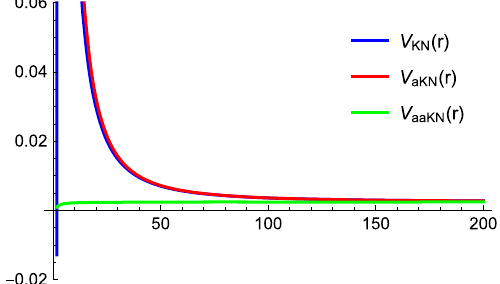
Fig. 2 (Left) potential without trapping well V KN ( r ) as function of r ∈ [ r + = 1 . 741 , 40 ] with M = 1 , Q = 0 . 6 ,ω = 0 . 02 , a = 0 . 3 , m = 1 , q = 0 . 1 ,λ lm = 12 ,μ = 0 . 05. V aKN ( r ) mimics V KN ( r ) for r ≥ 20.